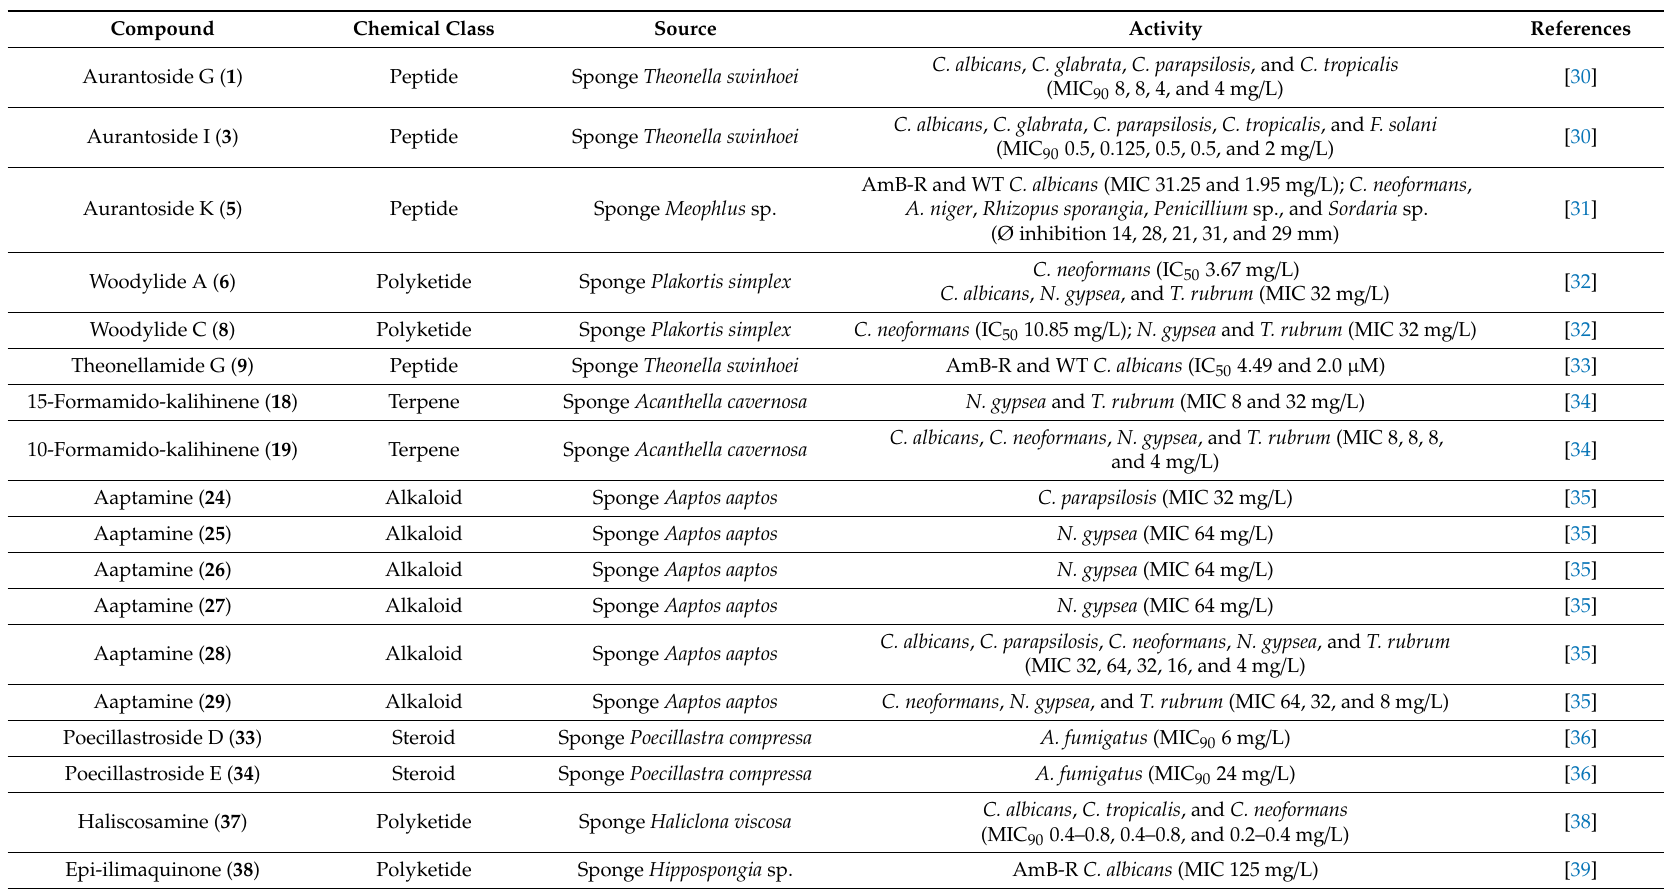
Table 1. The general characteristic of the marine natural products with antifungal